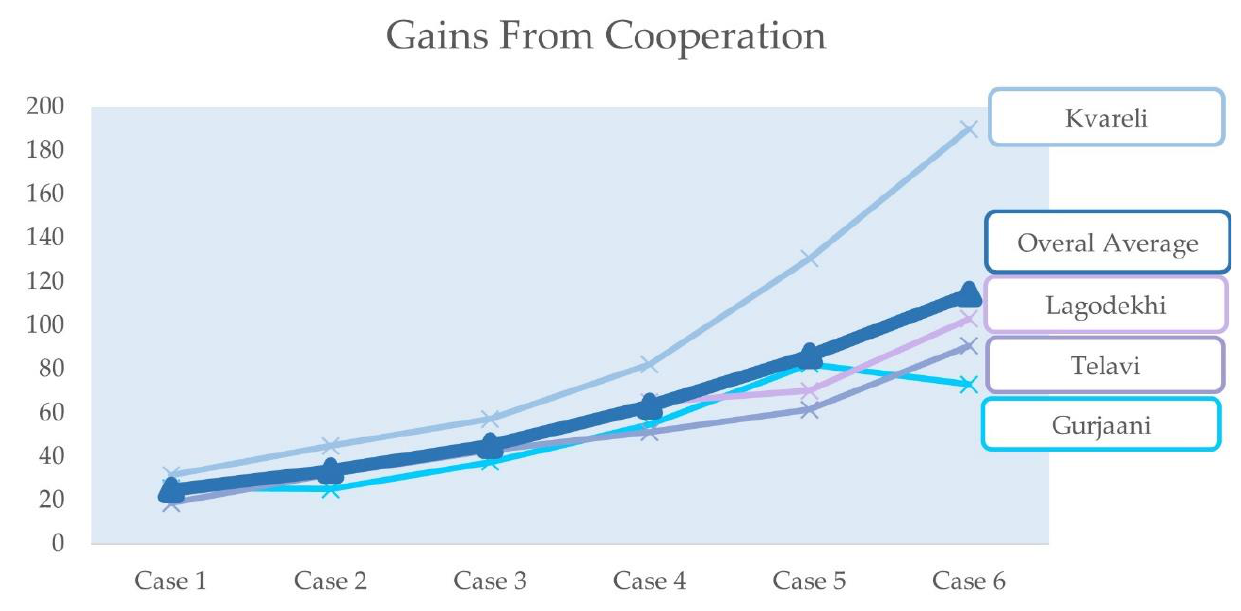
Figure 16. Distribution of cooperation levels in the public goods games.